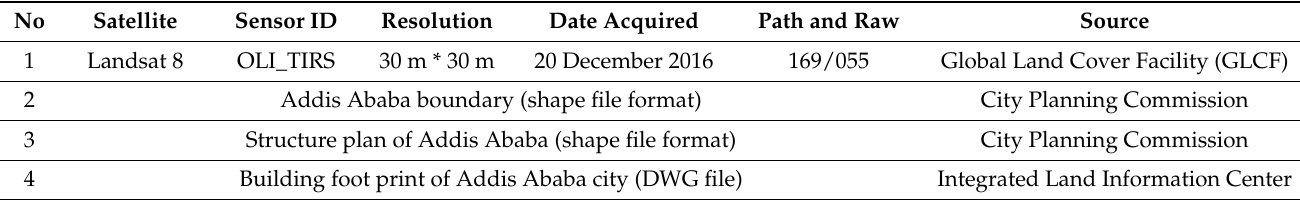
Table 2. Satellite image source, spatial resolution, and other spatial data